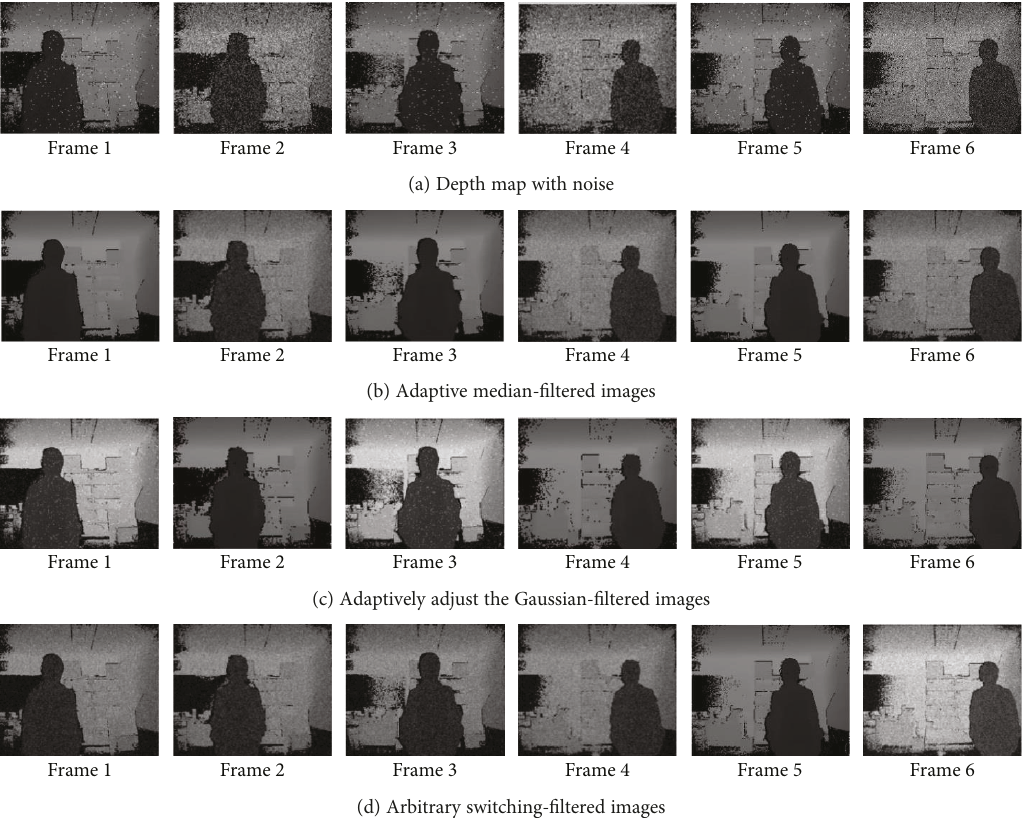
Figure 6: Filter results for the fi rst